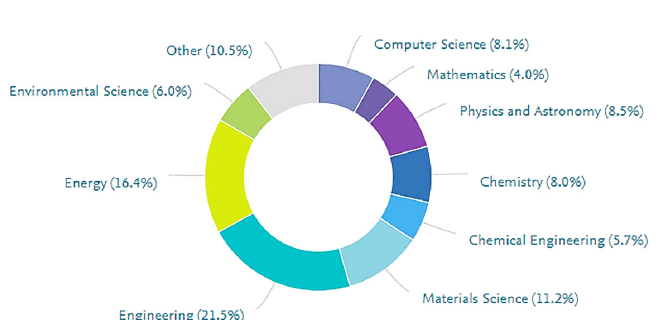
Figure A1. Structural analysis by subjects for the case of SDG 7